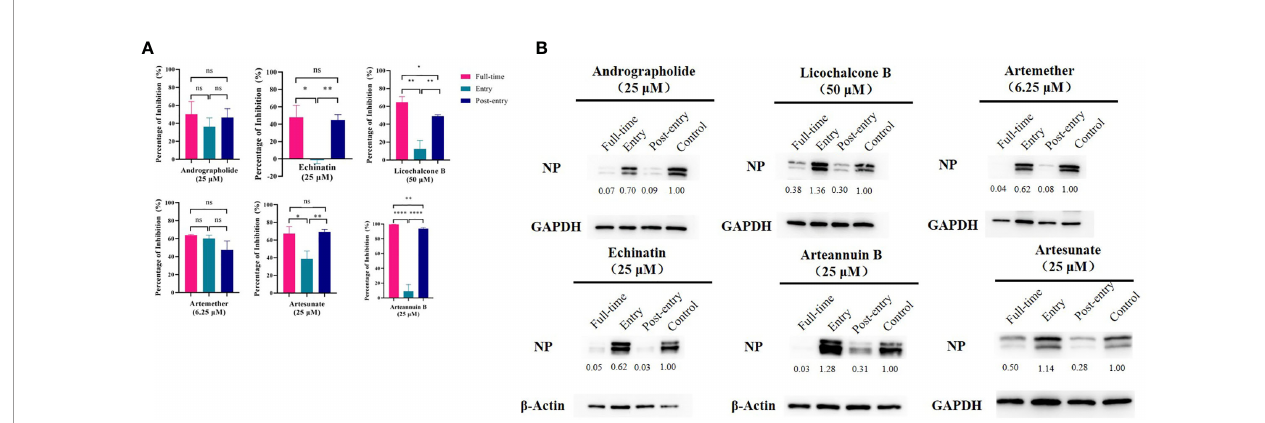
FIGURE 3 | (A) Time-of-addition assay and western blot of six monomer compounds in “ Three Medicines and Three Prescriptions ” . For “ Full-time ” treatment, the cells were treated with drugs immediately after infection with GX_P2V and incubated in the 37°C incubator with 5% CO 2 for 2 hours to allow the virus to adsorb. Afterwards, the virus – drug mixture was removed, and the cells were cultured with drug-containing medium until the end of the experiment. For “ Entry ” treatment, the drugs were added to the cells immediately after infection with the virus and at 2h.p.i., the virus – drug mixture was replaced with fresh culture medium and maintained till the end of the experiment. For “ Post-entry ” experiment, drugs were added at 2h.p.i., and maintained until the end of the experiment. For all the experimental groups, cells were infected with GX_P2V at an MOI of 0.01, and virus yield in the infected cells were quanti fi ed by qRT-PCR and (B) NP expression in infected cells was analyzed by western blot at 72h.p.i. The experiments were done in triplicates. *p < 0.1, **p < 0.01, ****p < 0.0001, ns, not signi fi cant.